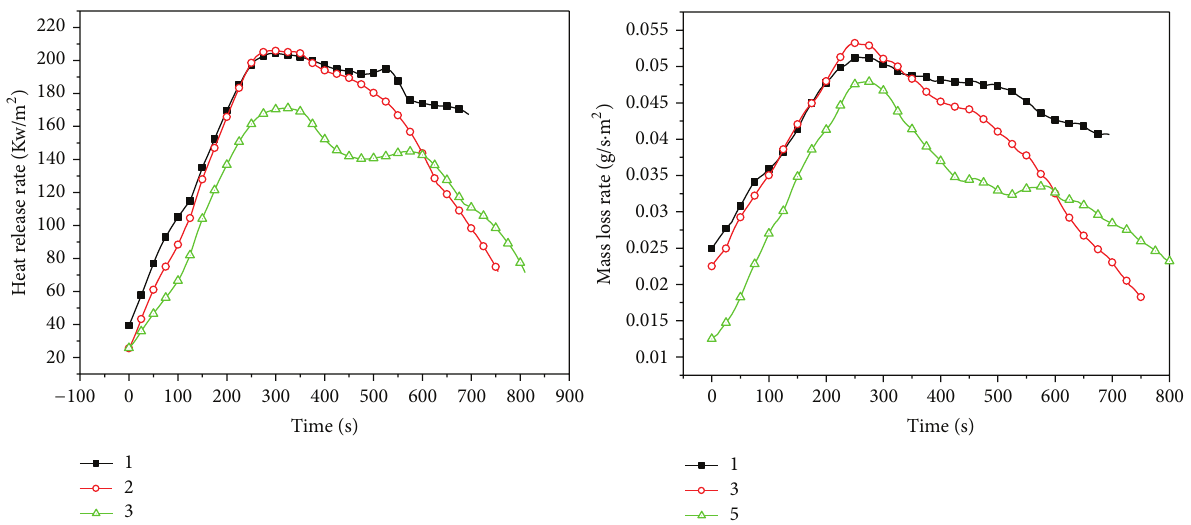
Figure 4: HRR and MLR curves as a function of time for PP/27%IFR, PP/27%IFR/3%PETA, and